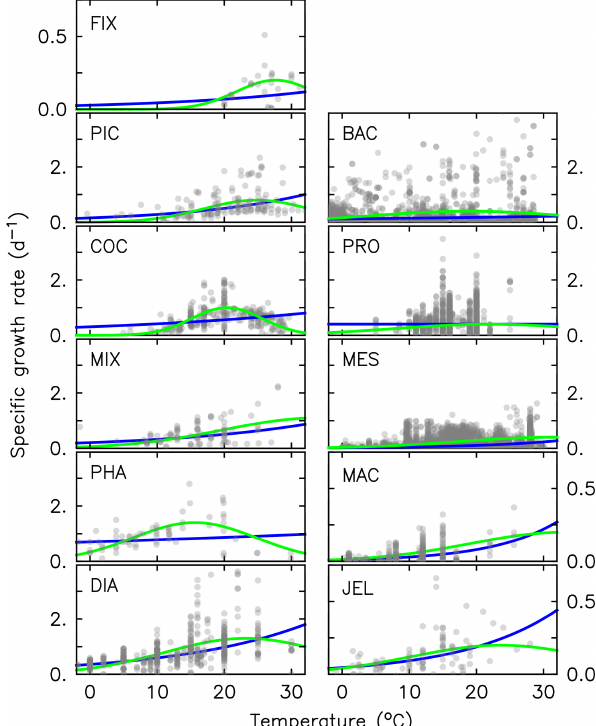
Figure 2. Maximum growth rates for the 11 PFTs as a function of temperature from observations (grey circles). The three-parameter fit to data is shown in green, and the two-parameter fit is shown in blue, using the parameter values from Table 2. For full PFT names see Table 1. The R 2 values for both fits to data are given in Ap- pendix Table